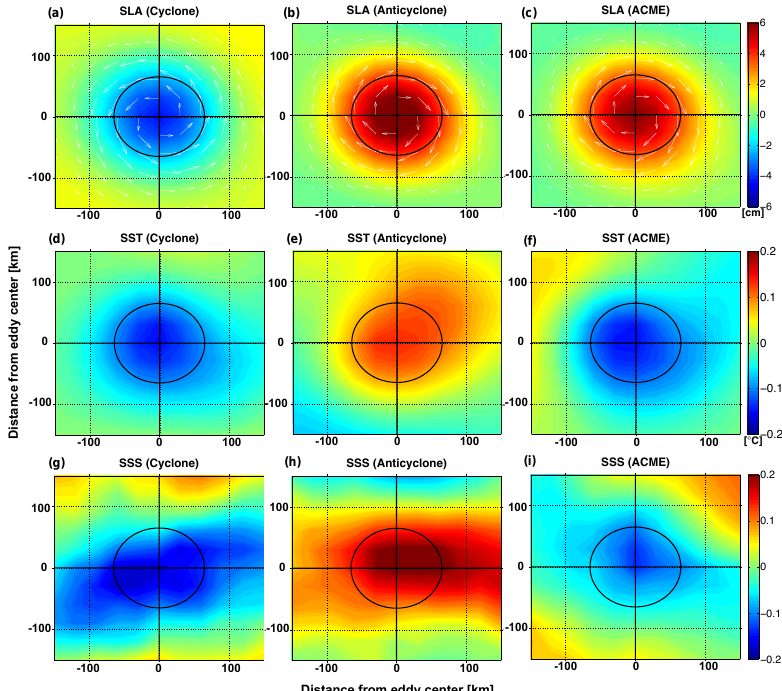
Figure 11. SLA, SST, and SSS anomalies of the composite cyclone, anticyclone, and ACME in the TANWA based on the results of the OW method. SLA (color) and the associated geostrophic velocity (white arrows) are shown for each eddy type in (a) , (b) , and (c) ; SST anomaly in (d) , (e) , and (f) ; and SSS anomaly in (g) , (h) , and (i) . The circles mark the mean eddy radius.